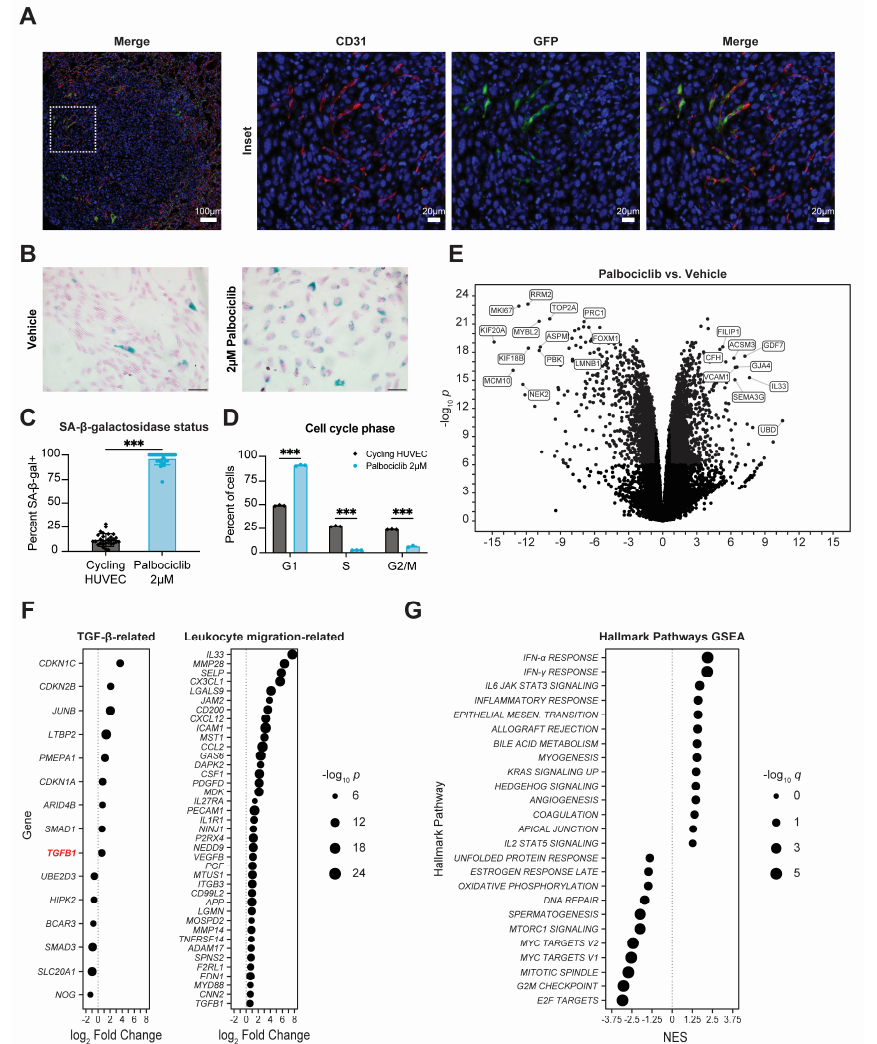
Figure 4. Palbociclib-treated endothelial cells demonstrate hallmark features of cellular senescence in vitro. ( A ) Representative immune fluorescence staining of E0771 metastases in palbociclib- pretreated lungs. Red = CD31; green = GFP; blue = Hoechst dye; scale bars = 100 µ m (overview image) or 20 µ m (insets). ( B ) Senescence-associated β -galactosidase expression status of HUVEC treated with 2 µ M palbociclib versus cycling HUVEC. Nuclear Fast Red counterstain with 50 µ m scale bar. ( C ) Quantification from ( B ): thirty non-overlapping 20 × fields captured per dose compared by unpaired t -test. ( D ) Cell cycle status of HUVEC treated with palbociclib for 72 h compared to cycling HUVEC, quantified by propidium iodide stain and flow cytometry. Three independent replicates per treatment condition compared by two-way ANOVA with Tukey’s multiple comparisons test. ( C , D ) All bars indicate mean ± standard error; *** p < 0.001. ( E ) Differentially expressed genes in HUVEC induced by 2 µ M palbociclib treatment for 72 h. Full list of differentially expressed genes in Supplemental File S2. ( F ) Differentially expressed genes in palbociclib-treated HUVEC from the MSigDB Hallmarks TGF- β signaling gene set or from the gene ontology annotation “leukocyte mi- gration” retrieved from AmiGO under accession number GO:0050900. Differentially expressed genes graphed reached statistical significance threshold of absolute value of log 2 fold change > log 2 (1.5) and p < 10 − 6 or were excluded. Size indicates significance level. ( G ) Gene set enrichment analysis (GSEA) of human MSigDB Hallmark gene sets associated with palbociclib treatment of HUVEC. Pathways graphed reached statistical significance threshold of absolute value of normalized enrichment score (NES) > 1.25 and q < 0.05 or were excluded. Size indicates significance